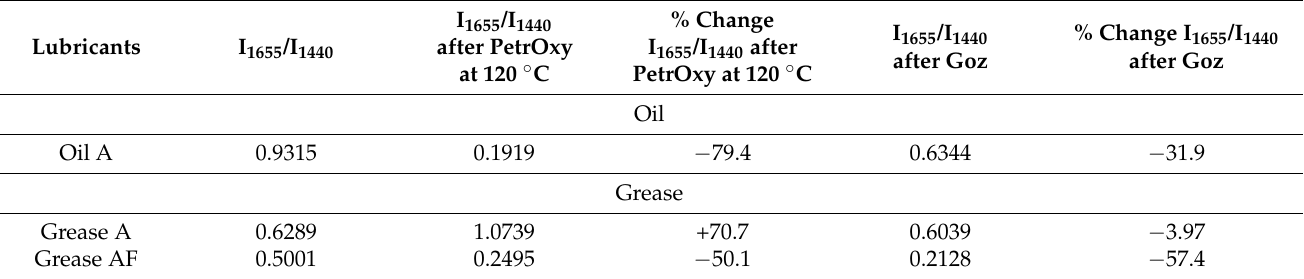
Table 2. The impact of excitation on the integral intensity of I 1655 /I 1440 bands.